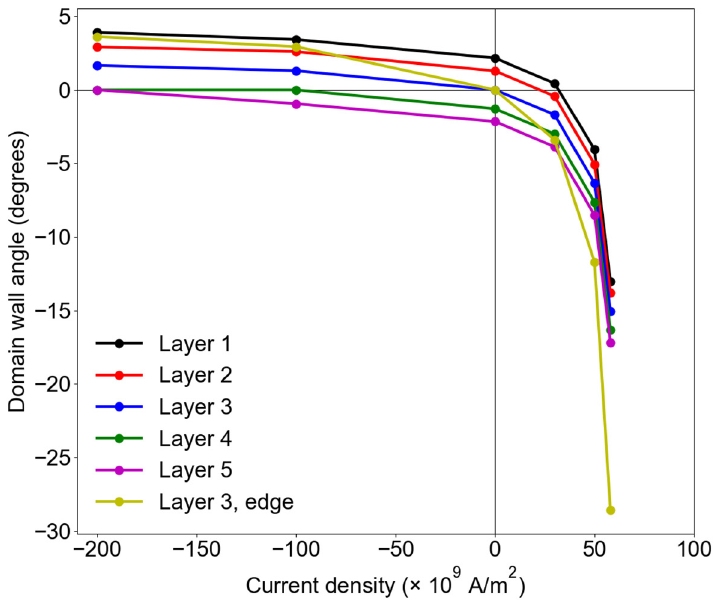
Figure 4. Domain wall structure at both top and bottom simulation cells at a current density of 58 kA/m 2 , immediately prior to reversal of the M y = − 1 domain wall.